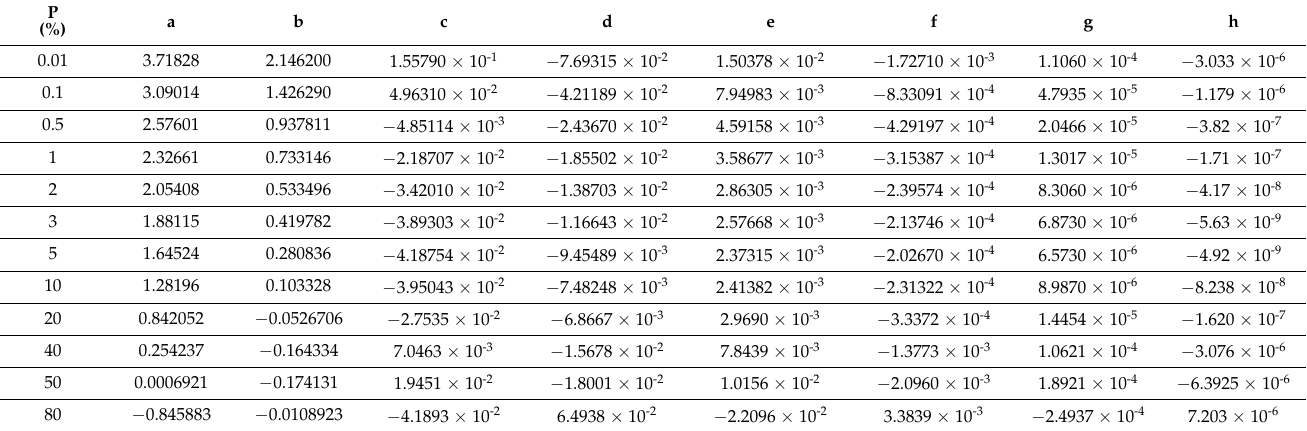
Table A2. The frequency factor for estimation with MOM for Pearson III.